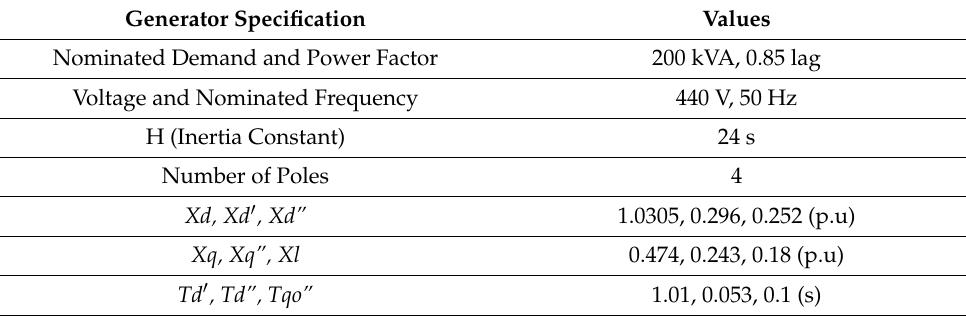
Table 3. Specifications of diesel generator of the proposed